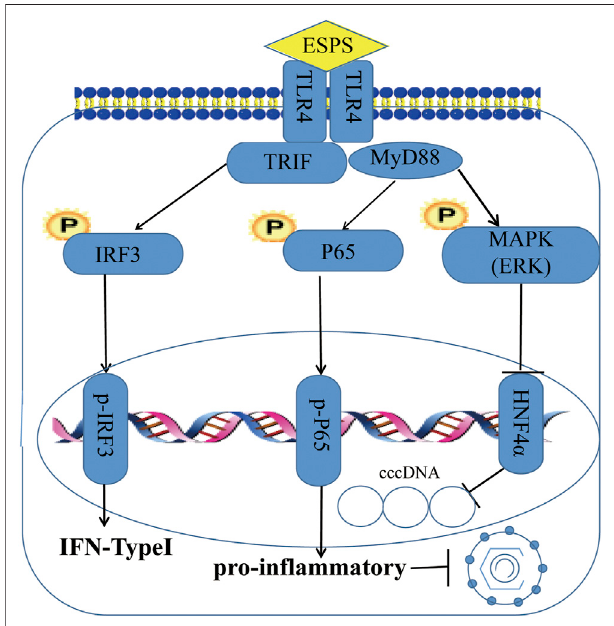
FIGURE 7 | Schema of ESPS against HBV. ESPS promotes the expression of TLR4, thereby activating interferon signaling pathway and in fl ammatory signaling pathway to play an indirect antiviral role, or activating ERK pathway to directly inhibit HBV promoter activity and inhibit HBV